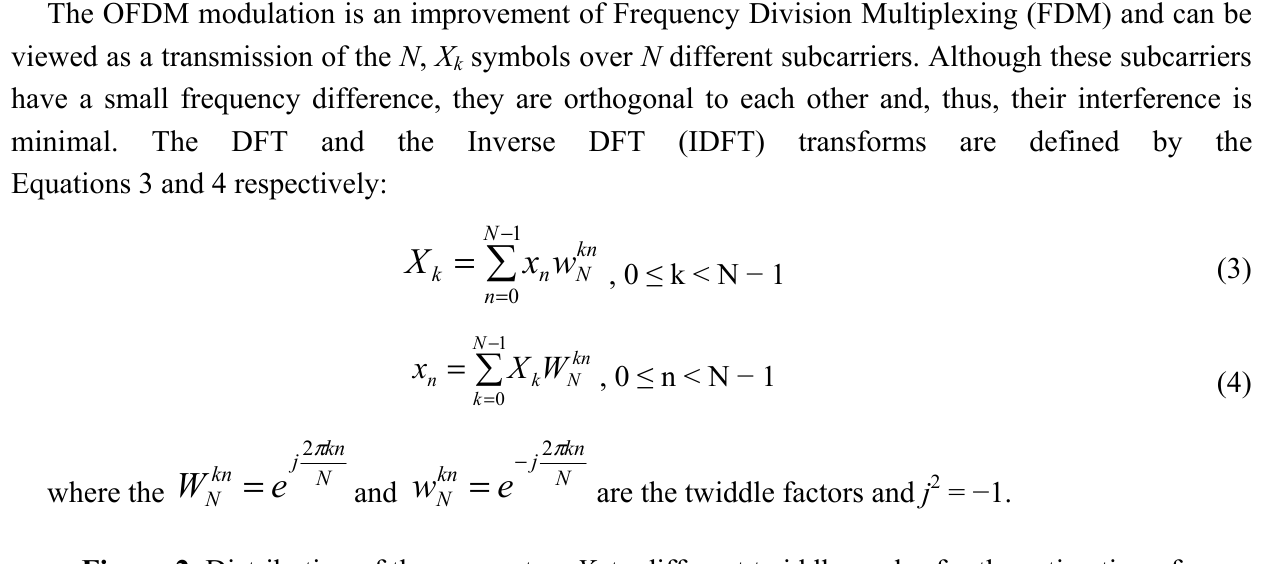
Figure 2. Distribution of the parameters X the x values in a 16-point n